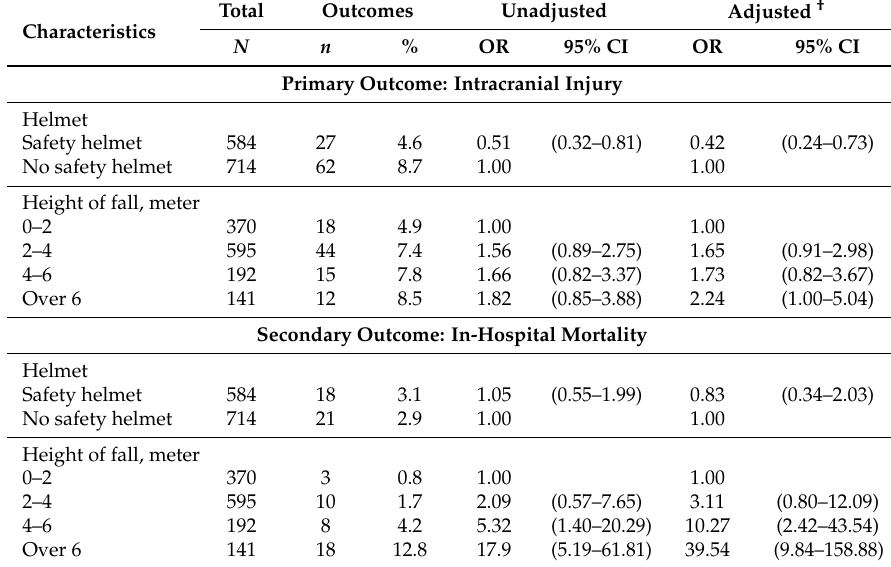
Table 3. Logistic regression analysis on study outcomes by safety helmet and height of fall injury.